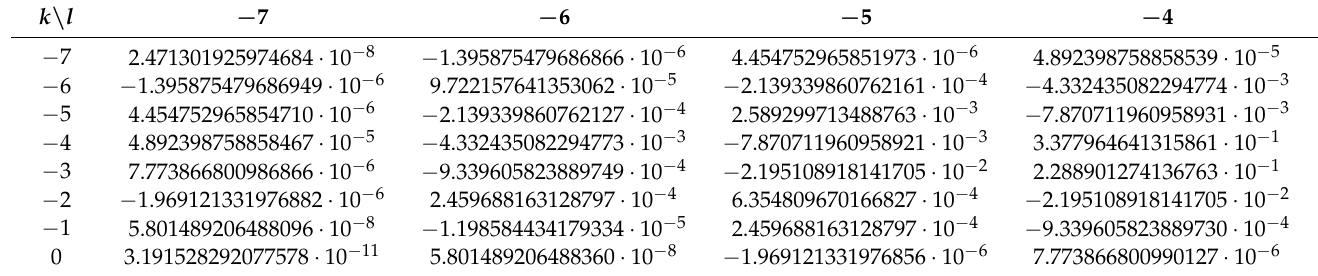
; [ 0,1 ]) evaluated up to machine precision. ( 3,1 )